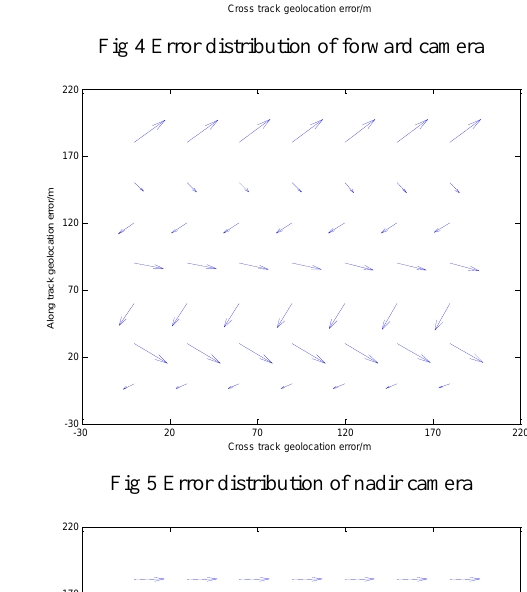
Fig 5 Error distribution of nadir camera